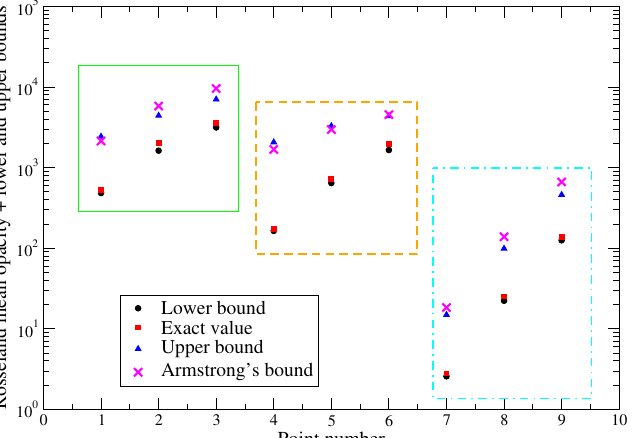
Figure 3. Comparison of the exact Rosseland mean, the two bounds provided by Equation (24), and Armstrong’s bound in the case of an iron-magnesium mixture plasma at three different temperatures, 100, 200, and 500 eV, and three different densities, 0.025, 0.25, and 2.5 g represents a temperature—green rectangle: T = 100 eV; orange rectangle: T = 200 eV; and blue rectangle: T = 500 eV. Inside each rectangle, each set of four points aligned vertically corresponds to a fixed temperature; from left to right: ρ = 0.025, 0.25, and 2.5 g